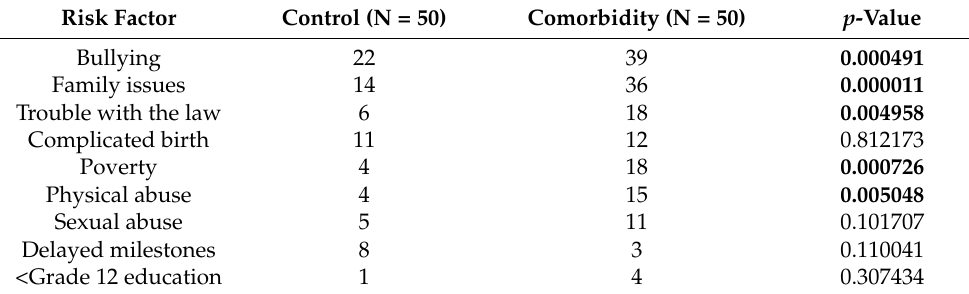
Table 5. Association of specific risk factors as compared to principal diagnosis. Risk